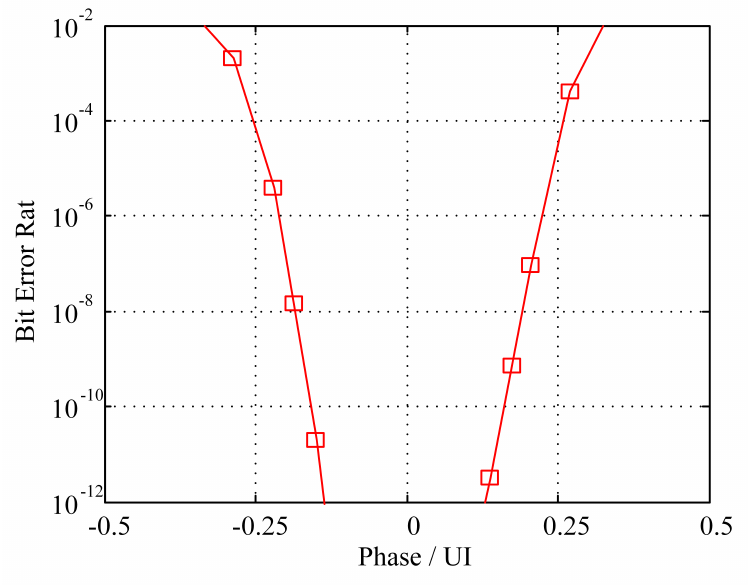
Figure 19. The bathtub